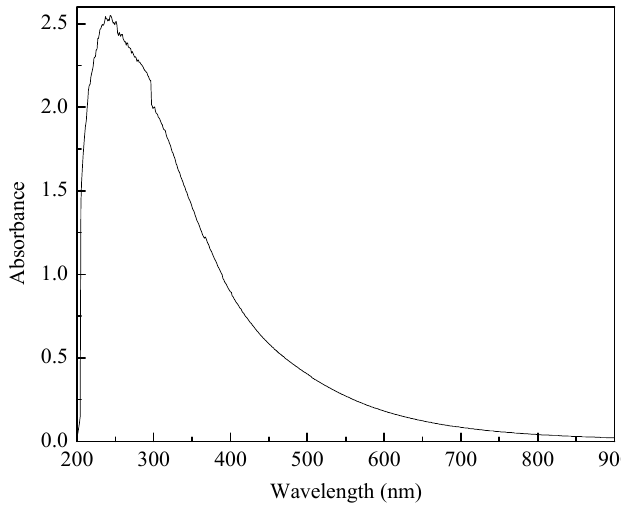
Figure 8. Ultraviolet–Visible (UV–VIS) spectra of HA.